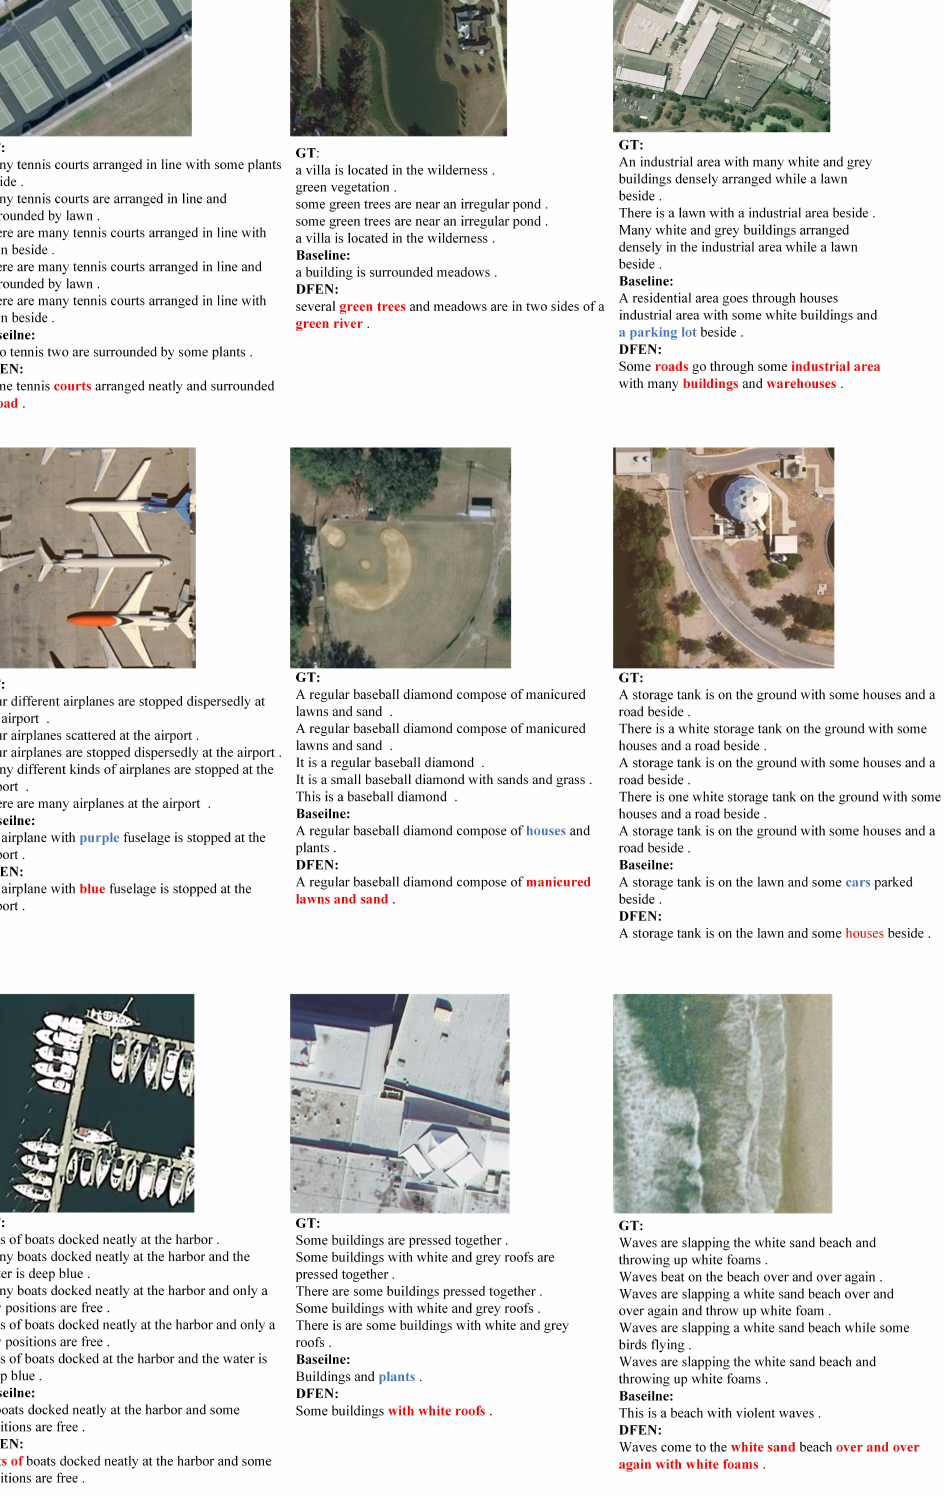
Figure 5. Comparison of experimental